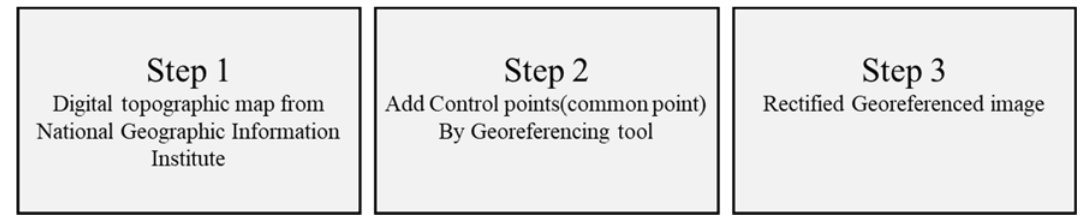
Figure 13. Steps of aerial image correction.